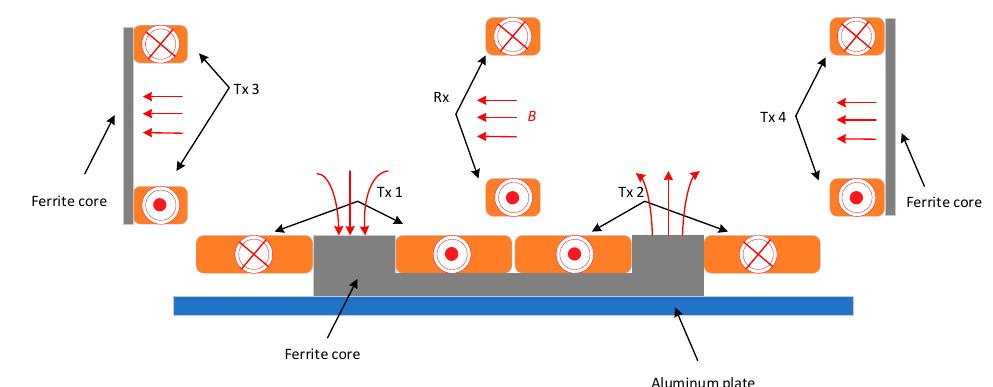
Figure 3. Magnetic field distribution of the coupled structure.